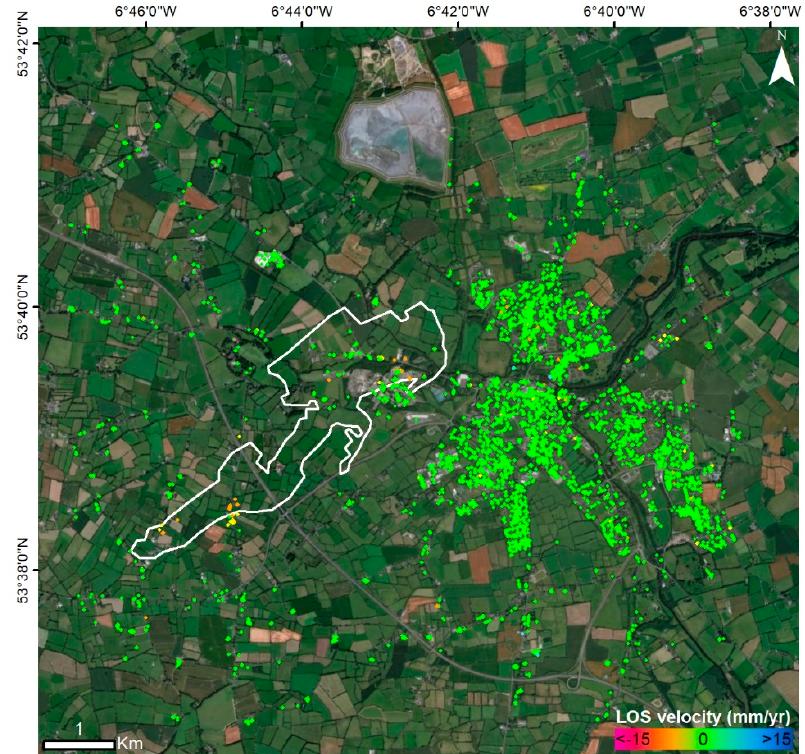
Figure 18. LOS velocity maps of AOI-1 obtained from ENVISAT images with the PS-InSAR approach. SAR imagery date range: November 2002–July 2010. The white polygon is the simplified subsurface extent of the Navan orebody (after [46] ). Base image source: Esri, DigitalGlobe, GeoEye, Earth Geographics, CNES/Airbus DS, USDA, USGS, AeroGRID, IGN, and the GIS User Community.